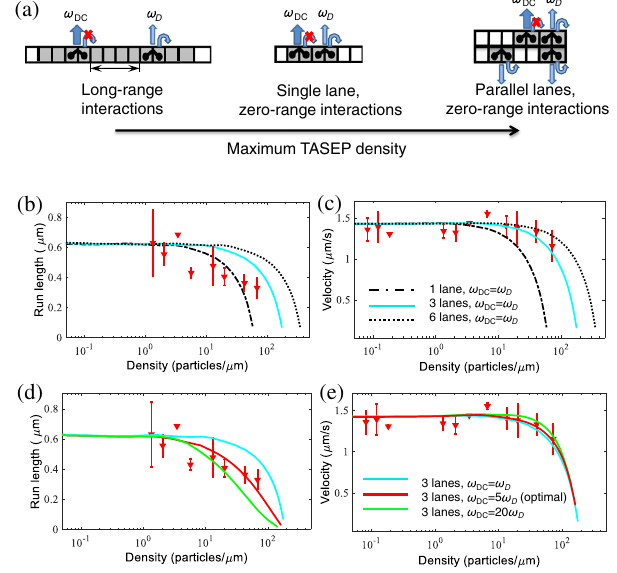
FIG. 5. Modeling of velocity and run length in the extended TASEP-LK model. (a) Schematic illustration of the density rescaling of the extended TASEP-LK model. Different motor interaction ranges and number of available lanes lead to different maximum density of the model. Three scenarios are shown: long- range interaction (low maximum density), short-range interaction of motors, single lane (medium maximum density), and short- range interaction of motors, parallel lanes (high maximum density). Note that ω is the detachment rate of constrained DC motors, which differs from the detachment rate of unconstrained motors ω in the extended model; this is illustrated by arrows of D different thickness. (b – e) TASEP-LK model predictions of run length and velocity for OSM-3 motor proteins performed in a PEM80 buffer. (b,c) Variation of the number of parallel lanes. The best fit of the experimental data (red triangles and error bars) is obtained with three parallel lanes. (d,e) Variation of the detach- ment rate ω of constrained motors for three parallel lanes. The DC ¼ 11 . 5 s − 1 (solid best fit for the run length is obtained with ω DC red curve), while the velocity is only weakly affected by ω DC